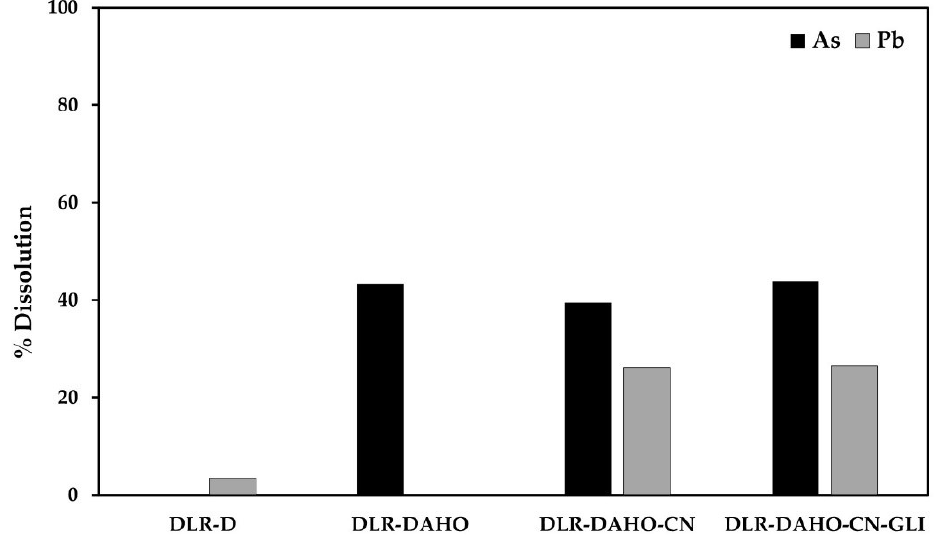
Figure 5. % Dissolution of As and Pb during conventional and glycine-assisted cyanidation of DLR- DAHO.